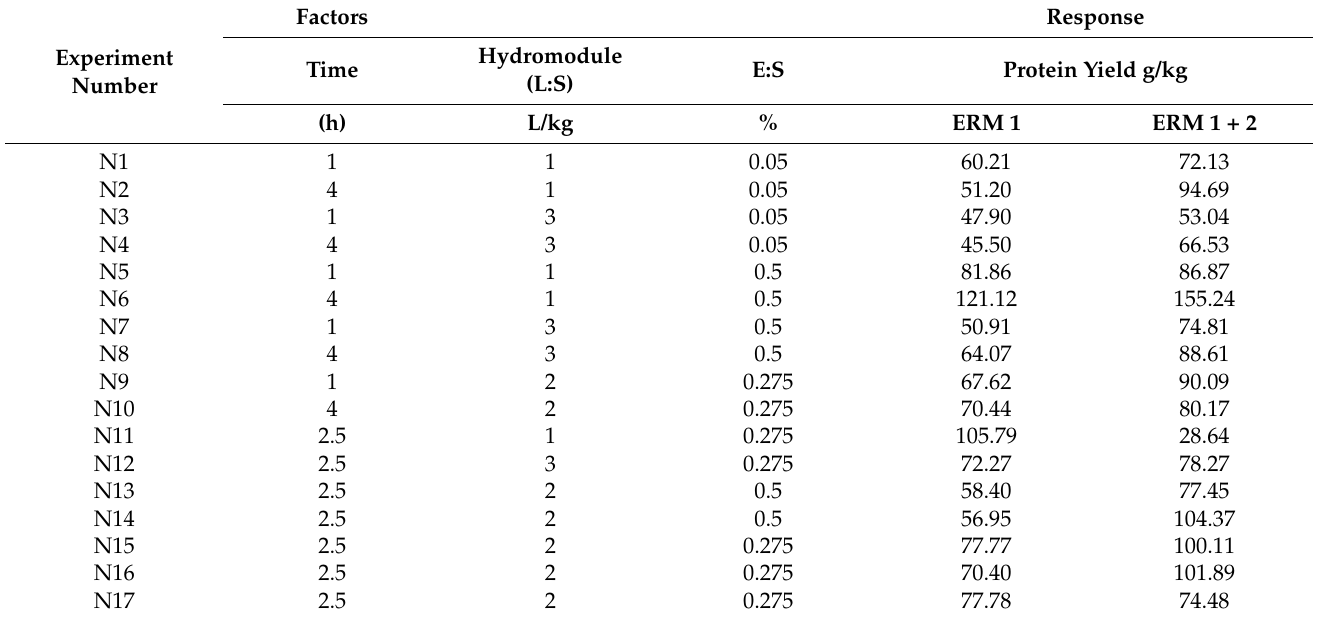
Table 1. CCF design for optimization of MDCM hydrolysis